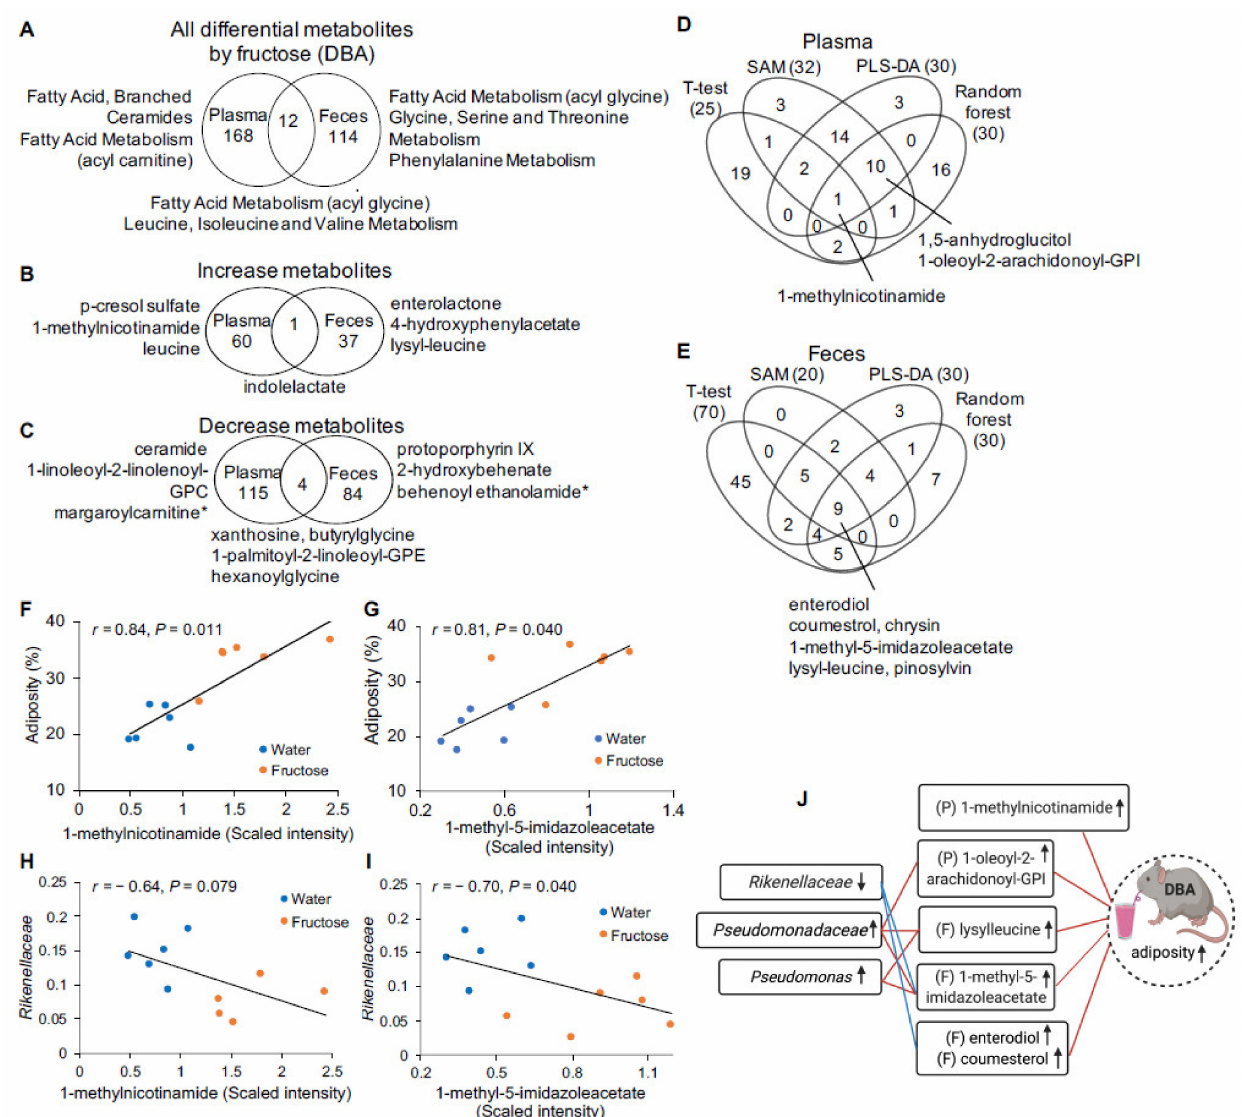
Figure 2. Fructose-responsive metabolites in plasma and feces of DBA mice. ( A ) Venn diagram showing the number of fructose-responsive metabolites and the representative pathways that were overlapping or unique between plasma and feces in DBA mice. ( B , C ) Venn diagram showing the number of the increased ( B ) and decreased ( C ) metabolites by fructose and the top metabolites that were overlapping or unique between plasma and feces in DBA mice. ( D , E ) Venn diagrams representing overlapping significant metabolites altered by fructose in plasma ( D ) and feces ( E ) across four statistical methods: statistical significance ( t -test/fold change), Significance Analysis of Metabolites (SAM), Partial-least squares discriminant analysis (PLS-DA), and Random forest. ( F – I ) Correlation plots of metabolites with the adiposity phenotype ( F , G ) and fructose-responsive microbiota (proportion, 0–1) ( H , I ) in DBA mice with and without fructose treatment. r, Biweight midcorrelation (bicor) coefficient; P , Benjamini-Hochberg adjusted p -values (FDR). ( J ) Summary of the correlation between fructose-responsive microbiota, metabolites, and metabolic phenotype (adiposity) of DBA mice. Increased or decreased levels of microbiota, metabolites, and metabolic phenotype (adiposity) upon fructose consumption were indicated by up or down arrows, respectively. P, plasma; F, feces. n = 5–6/group/strain. Fructose-responsive metabolites were determined by ANOVA contrasts ( p < 0.05). Symbol (*) next to metabolite indicates that the compounds have not been officially confirmed based on a standard, but that we are confident in its